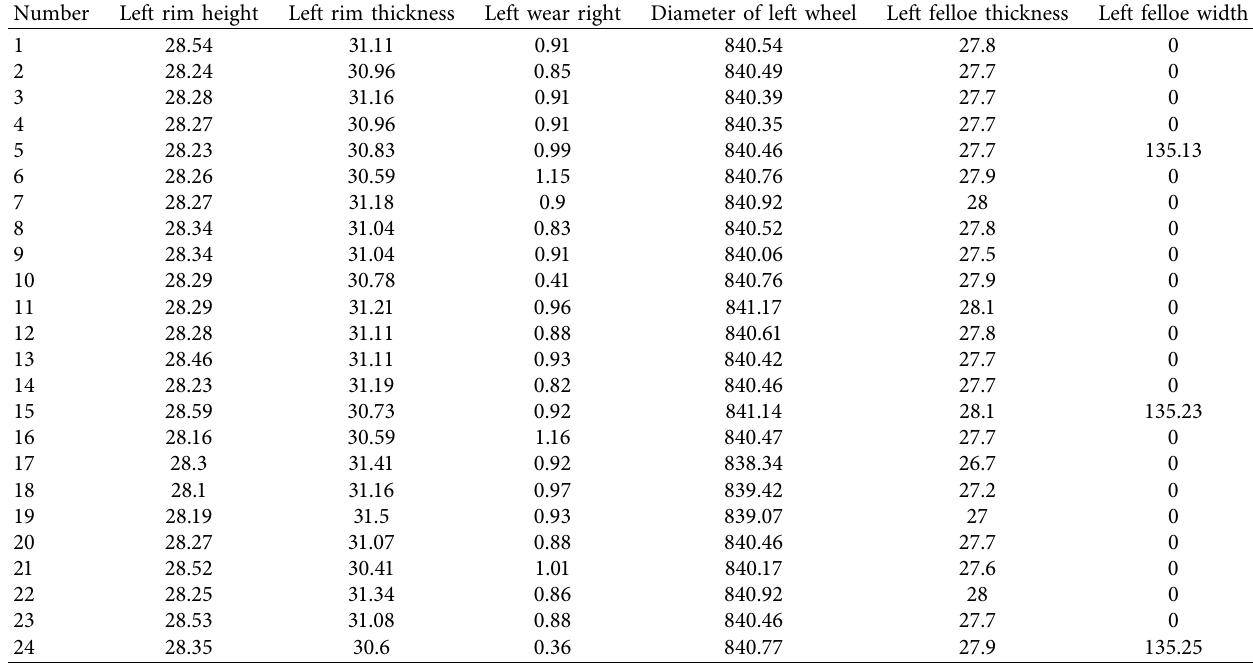
Table 2: Main parameters of left wheel.